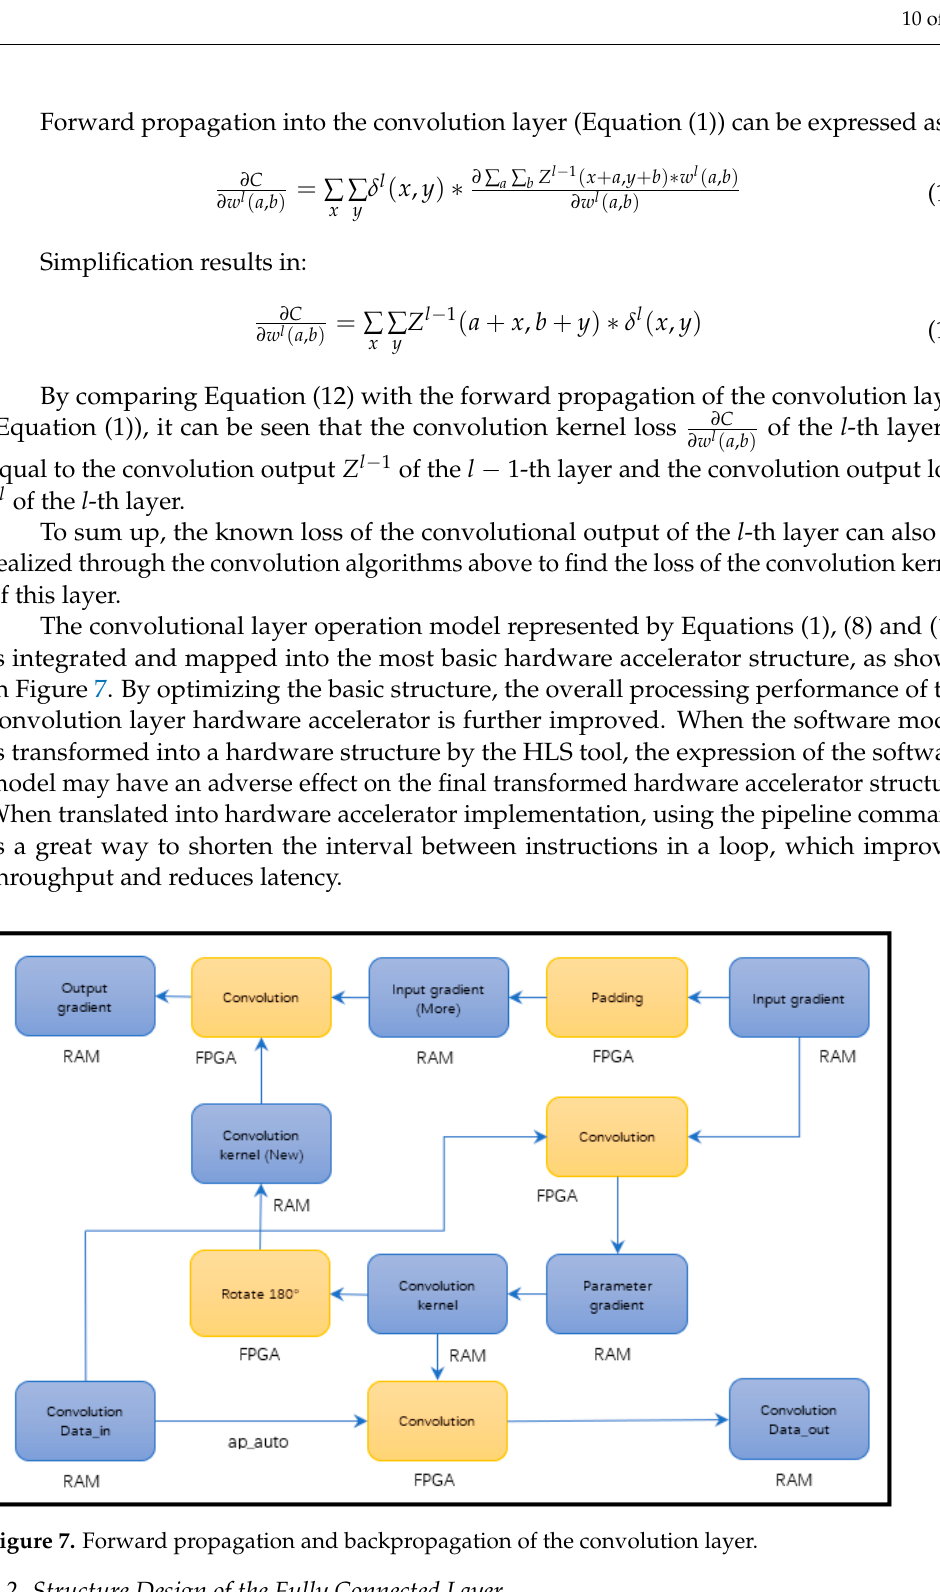
Figure 8. Data propagation at the full connection layer. 4.2.1. Fully Connected Layer Multiplication Structure Fully connected forward propagation is expressed as: 𝑍 𝑙 = 𝑊 𝑙 ∗ 𝑎 𝑙− 1